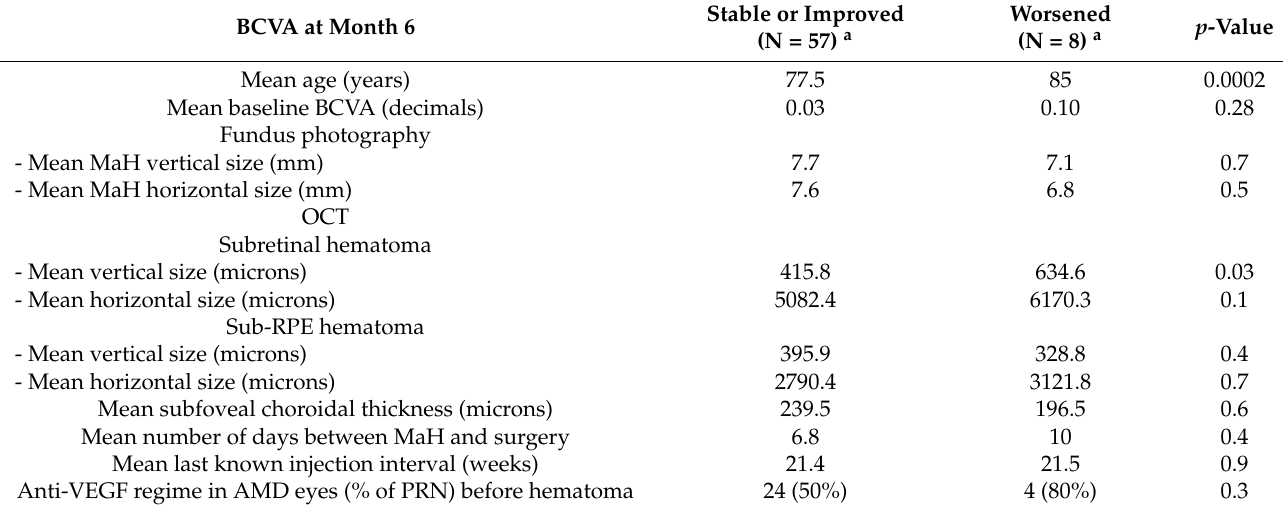
Table 3. Predictive factors of best corrected visual acuity outcomes at 6